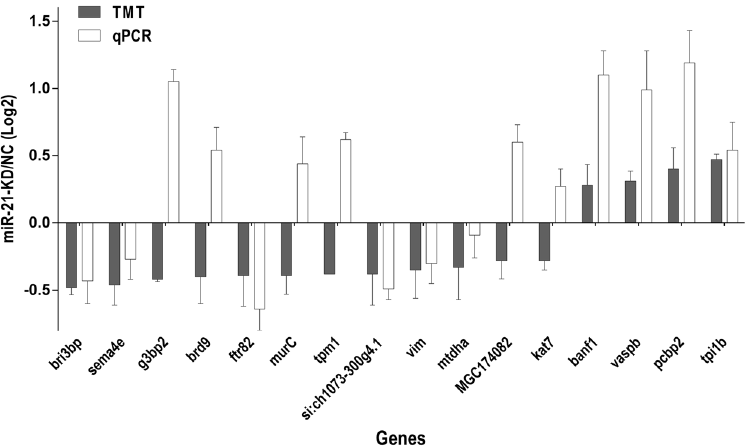
Figure 4. The mRNA expression level of the DEPs as detected by qRT-PCR. Comparison of log2 expression of 16 selected DEPs measured by TMT proteomic analysis and qPCR. Positive and negative log2 expression ratios represent up- and down-regulation after miR-21 Knockdown